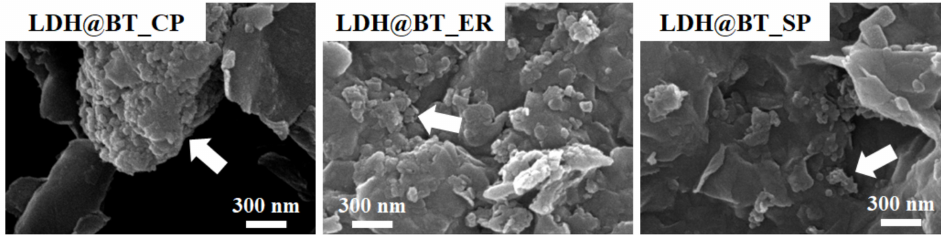
Figure 3. The SEM images of the LDH–BT_CP, LDH–BT_ER, and LDH–BT_SP (the white arrows indicate the LDH